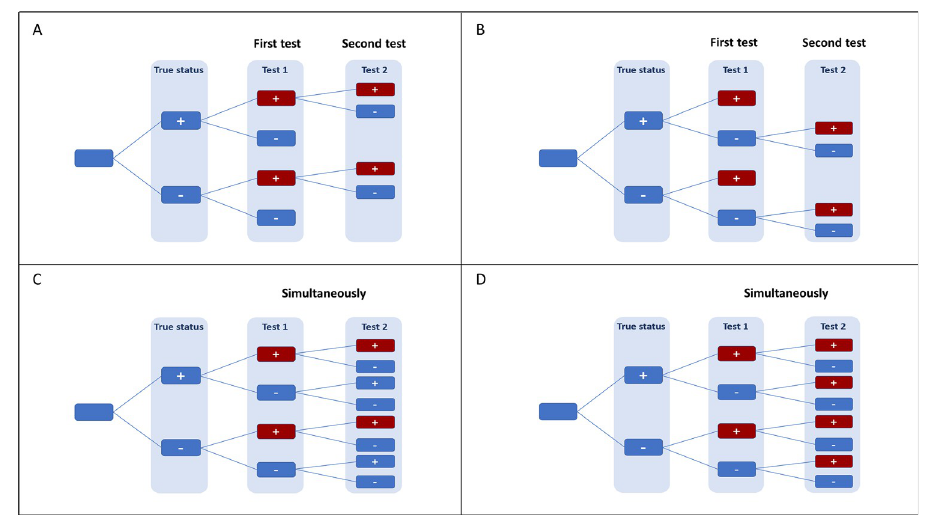
Fig 1. Testing strategies. A. Confirmatory testing for positives, meaning every positive test triggers a follow up test. B. Confirmatory testing for negatives, meaning that every negative triggers a follow-up test. C. Simultaneous testing, meaning that both tests are performed at the same time and the patient is considered to have a positive result if both are positive. D. Simultaneous testing, meaning that both tests are performed at the same time, and if either test is positive the patient is considered to have a positive